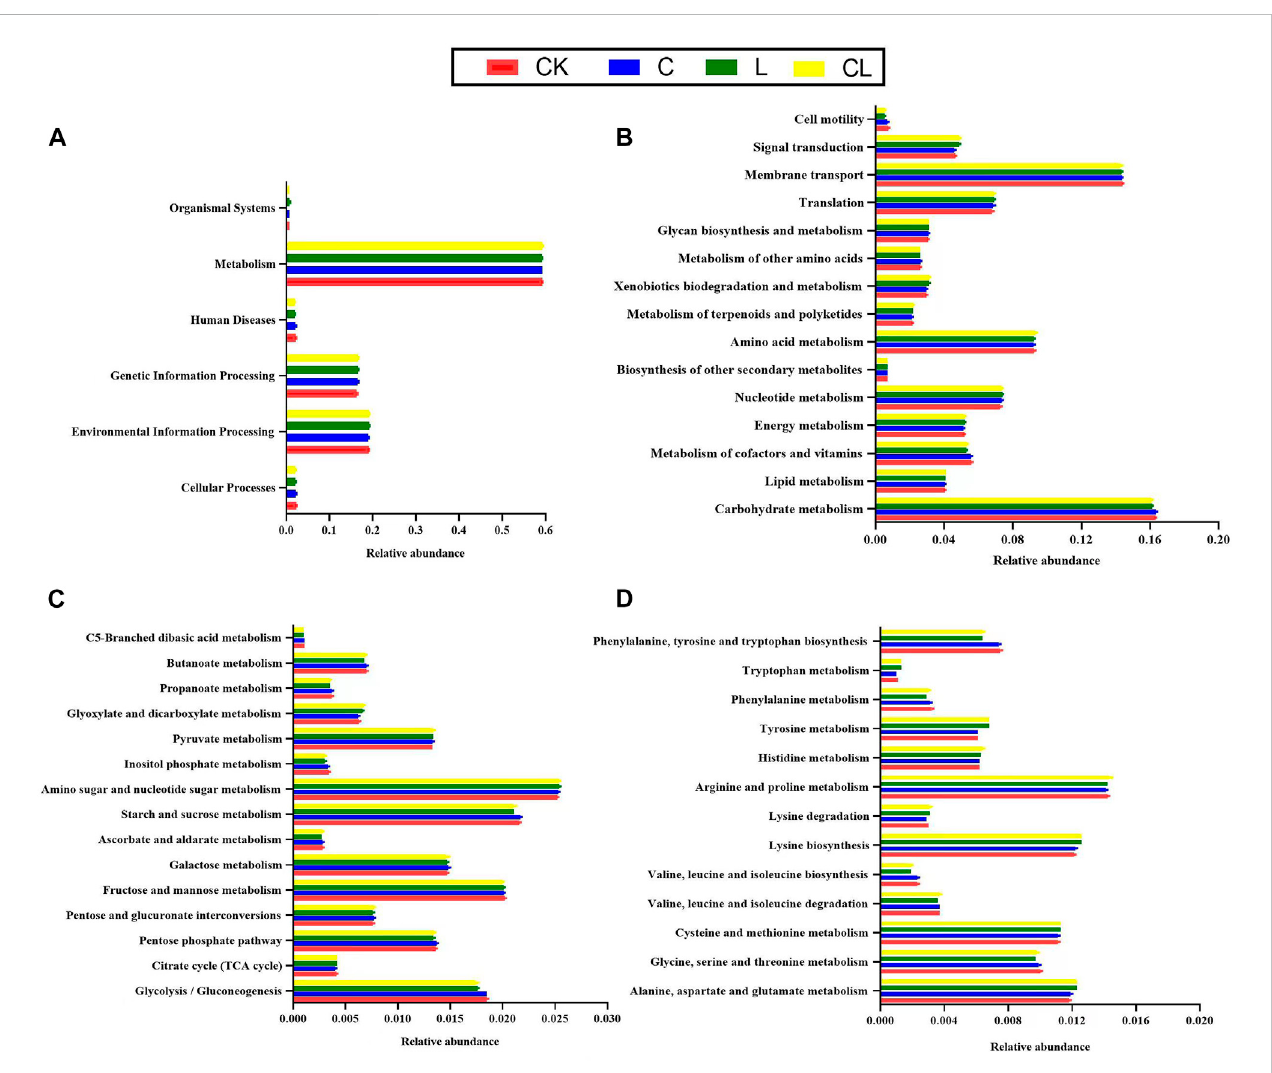
FIGURE 5 Predicted functional pro fi les of the 16S rRNA genes of the Kyoto encyclopedia of genes and genomes metabolic pathway in the fi rst (A) and second (B) metabolicpathways,carbohydratemetabolism (C) ,andaminoacidmetabolism (D) indifferentgroupsasdeterminedbyTax4Fun;CK,noadditive;C,cellulase; L, Lactiplantibacillus plantarum ( L. plantarum ); and CL, cellulase + L. plantarum